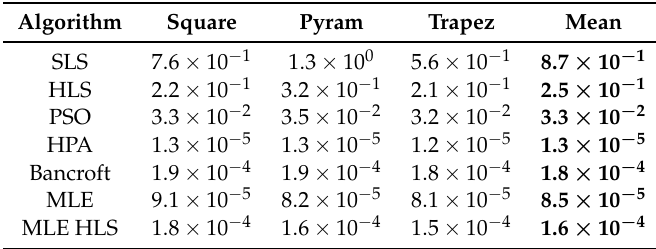
Table 9. Summary of the mean computational time spent, in seconds, for each position analysed under digitizing error in time variables by each